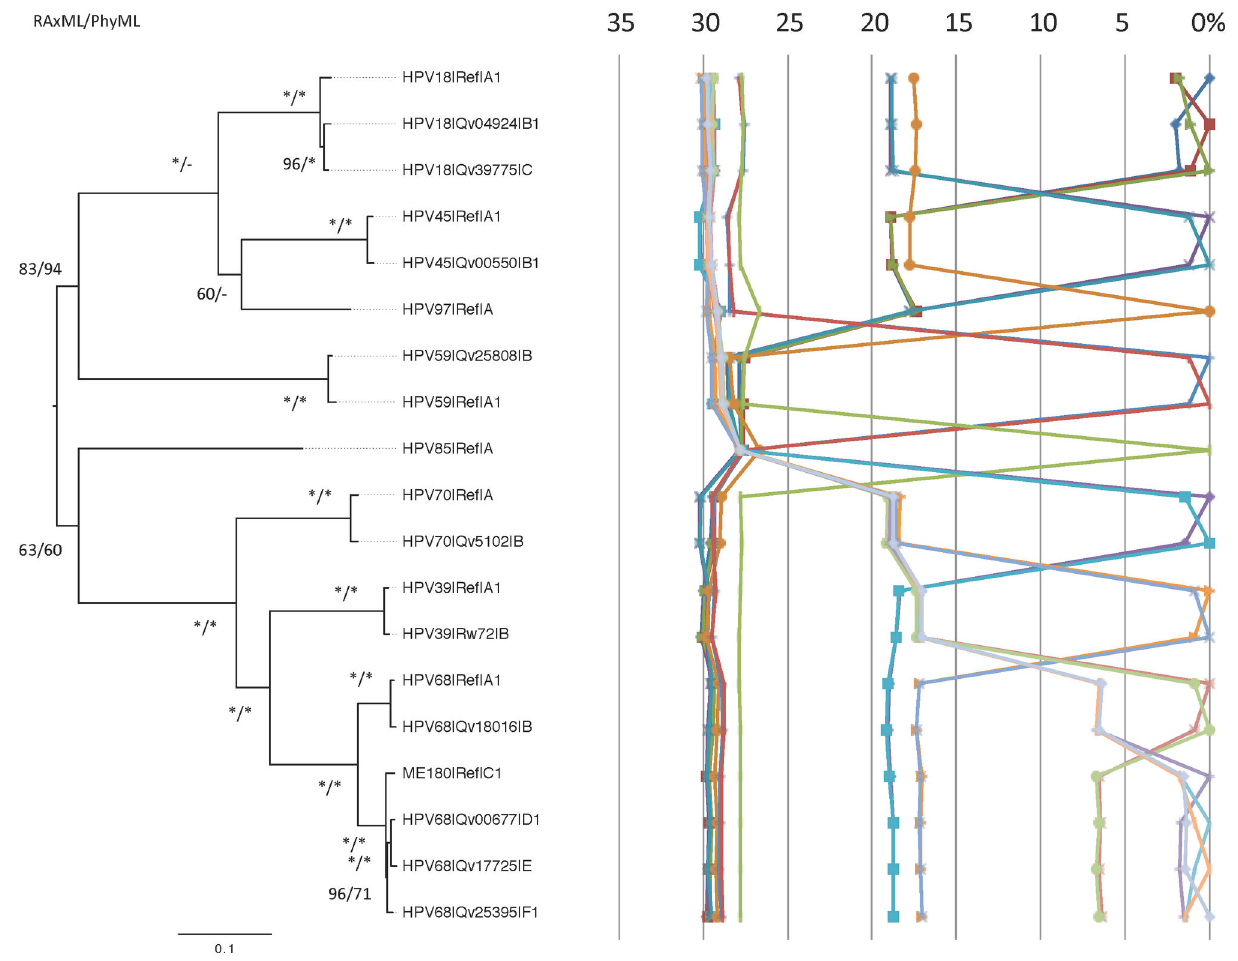
Figure 8. Phylogenetic tree and pairwise comparisons of representative Alpha-7 lineages and sublineage complete genomes. The phylogenetic tree was constructed as described in Figure 2. Representative genomes for each variant lineage and sublineage described in this report are used and the names of the isolates are shown to the right of the tree branches. The percent nucleotide sequence differences are shown in the panel to the right of the phylogenetic tree as described in Figure 2. doi: